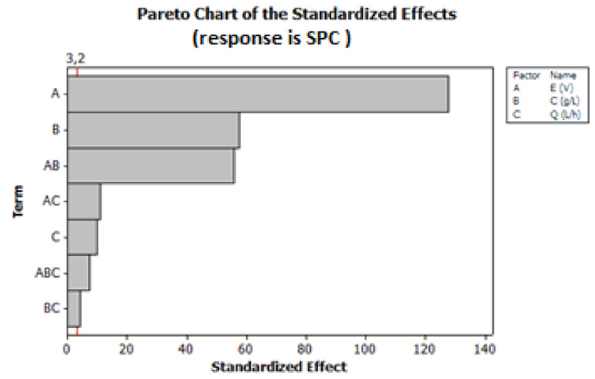
Fig. 3 Pareto chart for standardized effects for